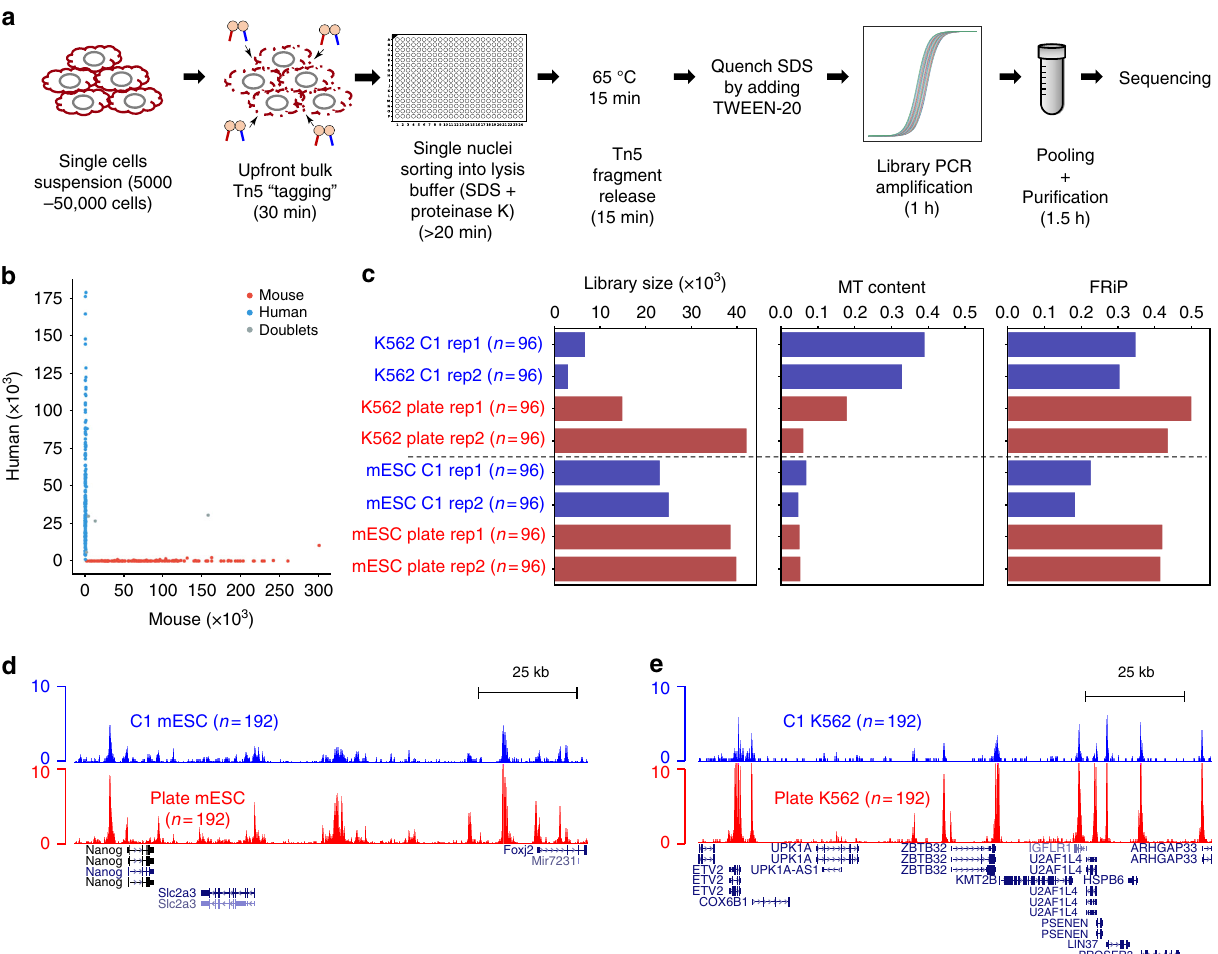
Fig. 1 Simple and robust analysis of chromatin status at the single cell level. a Schematic view of the work fl ow of the scATAC-seq method. Tagmentation is performed upfront on bulk cell populations, followed by sorting single-nuclei into 96/384-well plates containing lysis buffer. The lysis buffer contains a low concentration of proteinase K and SDS to denature the Tn5 transposase and fragment the genome. Tween-20 is added to quench SDS 14 . Subsequently, library preparation by indexing PCR is performed, and the number of PCR cycles needed to amplify the library is determined by quantitative PCR (qPCR) (Supplementary Figure 2b). b Species mixing experiments to show the accuracy of FACS. Equal amounts of HEK293T (Human) and NIH3T3 (Mouse) cells were mixed, and scATAC-seq was performed as described in a . Successful wells with more than 90% of reads uniquely mapped to either human or mouse were categorised as singlets ( n = 303). Otherwise, they will be categorised as doublets ( n = 4) (see Methods). c Comparison of the median library size (estimated by the Picard tool), fraction of mitochondrial DNA (MT content) and fraction of reads in peaks (FRiP) in single cells from either C1 (blue) or plate-based (red) scATAC-seq approach. d UCSC genome browser tracks displaying the signal around the Nanog gene locus from the aggregate of mESCs obtained from Fluidigm C1 (top) and plate (bottom). e The same type of tracks as d around the ZBTB32 gene locus in K562 visualised the data by t-distributed stochastic neighbour embedding (t-SNE) 19 . We did not observe batch effects from the two pro fi led spleens, and several distinct populations of cells were clearly identi fi ed in the t-SNE plot (Fig. 3d). Read counts in peaks near key marker genes (e.g. Bcl11a and Bcl11b ) suggested that the major populations are B and T lymphocytes, as expected in this tissue (Fig. 4a). In addition, we found a small number of antigen-presenting cell populations (Supplementary Figure 5), consistent with previous analyses of mouse spleen cell composition 20 .